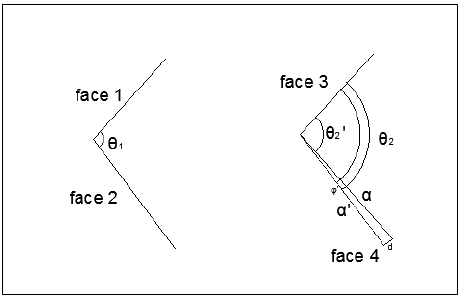
Figure 2. Comparison of angle θ 1 and angle θ 2 .